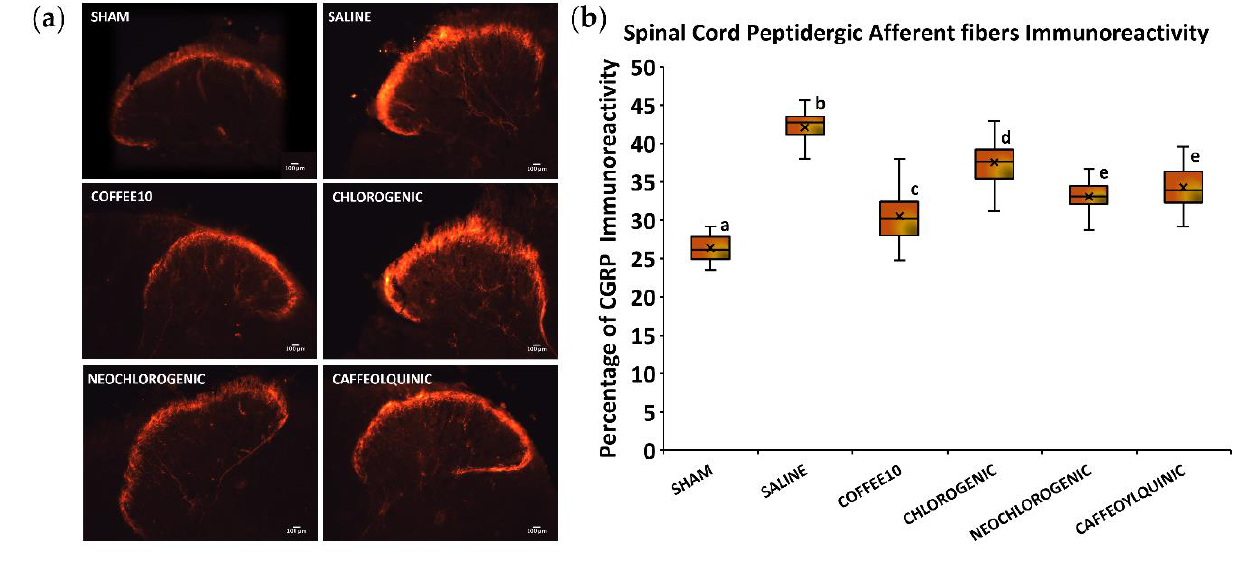
Figure 5. Sprouting of peptidergic afferent nerve fibers in the spinal cord after polyphenolic treat- ments fourteen days post-injury: ( a ) Representative CGRP images for each group. Scale bars = 100 µ m. ( b ) Percentage of dorsal horn CGRP-immunoreactivity. Data are illustrated as median ± IQR, and the x indicate the mean. a–e: not sharing a letter means significant differences, p < 0.05.